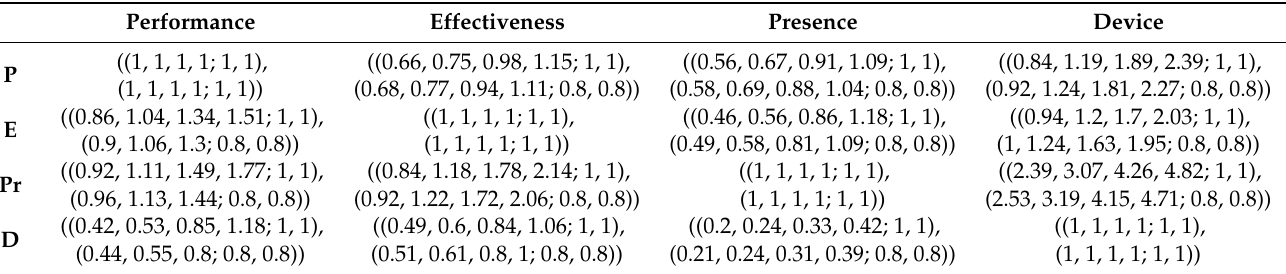
Table 2. Aggregated IT2F comparison matrix Level 1.